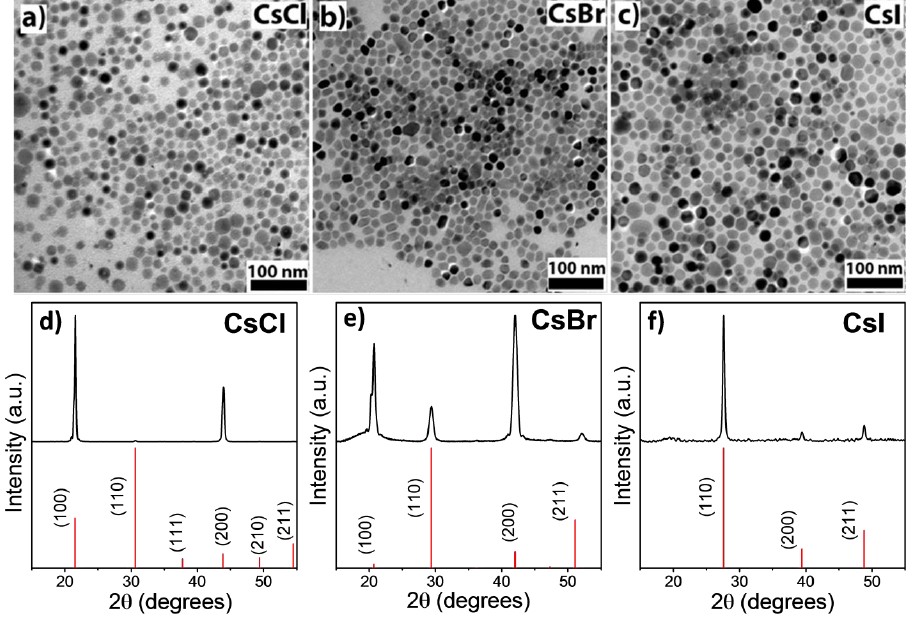
Figure 1. ( a )–( c ) TEM micrographs of obtained CsX nanocrystals, and ( d )–( f ) corresponding XRD patterns. Reference patterns for CsX are also included as references: CsCl (00-005-0607); CsBr (00-005-0588); CsI (00-006-0311).